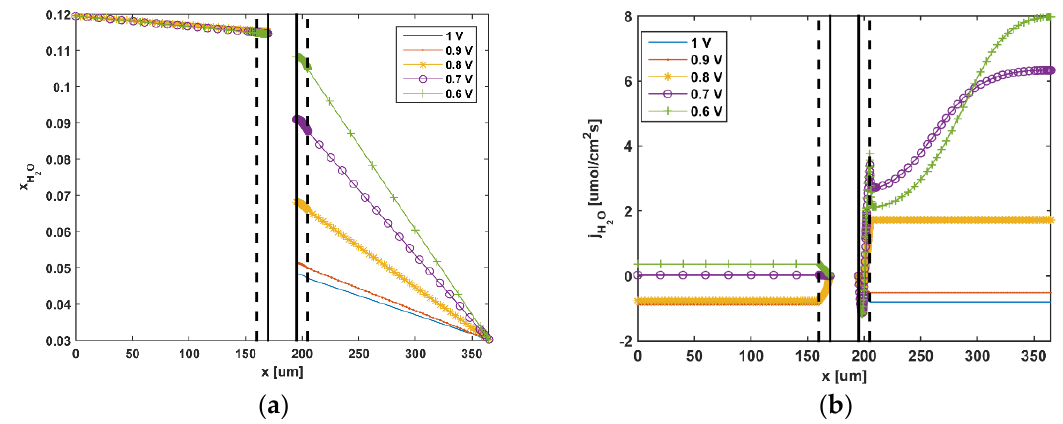
Figure 9. Evolution of the water vapor profiles on through-plane ( a ) water vapor diffusion profile; ( b ) water vapor flux profile.